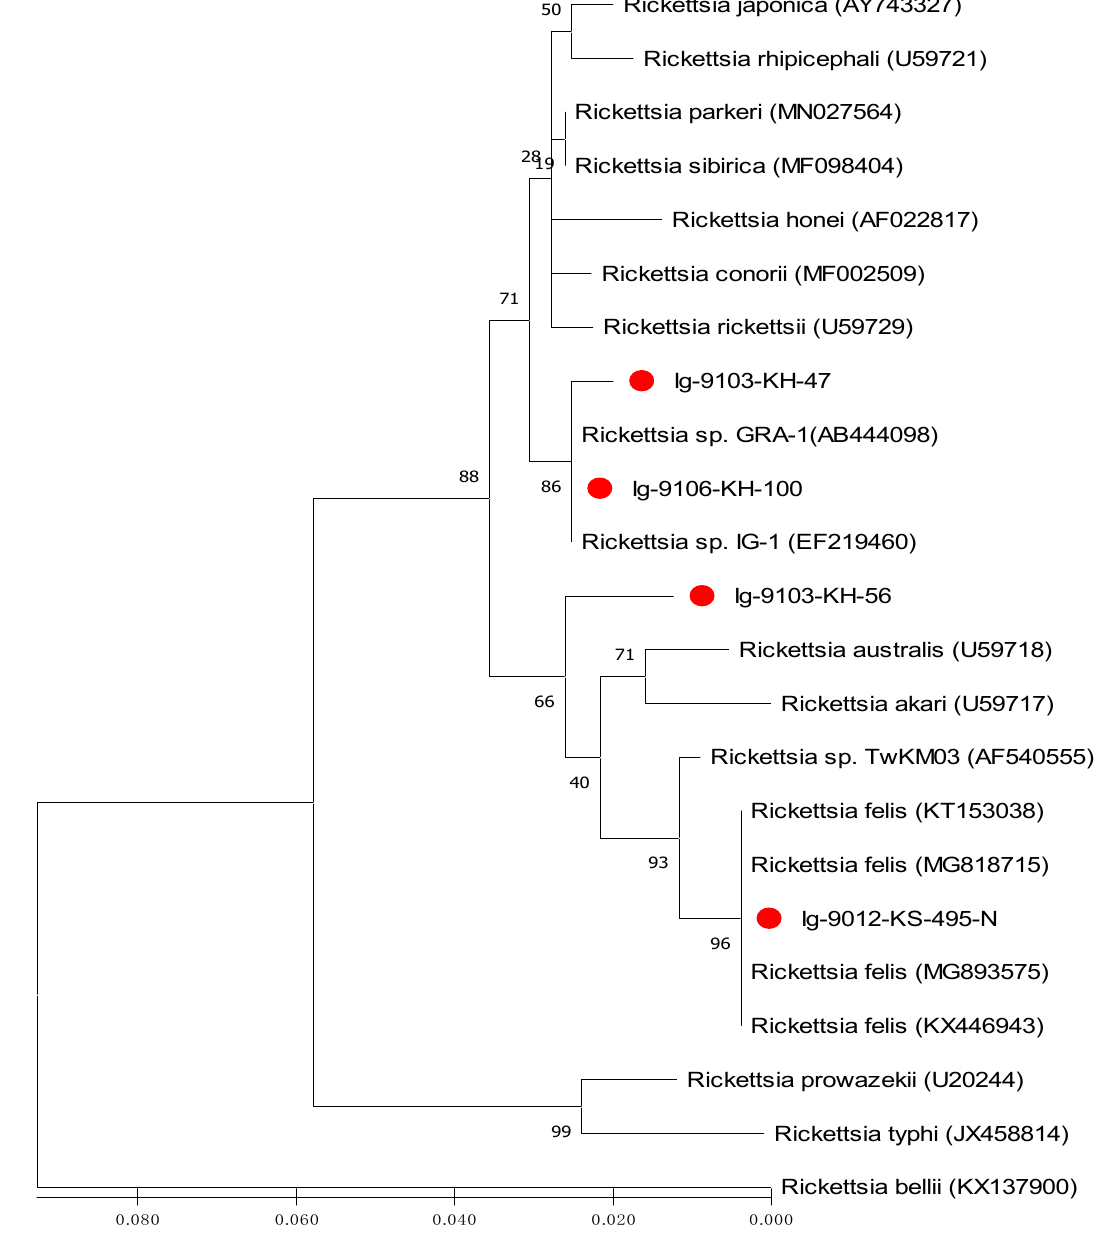
Figure 3. Phylogenetic relationships based on the citrate synthase gene ( gltA ) sequences of Rickettsia between 4 specimens (indicated as ●) collected from Ixodes granulatus ticks of Kinmen Island and 19 other Rickettsia specimens identified from various biological and geographical origins. The tree was constructed and analyzed by maximum likelihood (ML) method using 1000 bootstraps replicates. Numbers at the nodes indicate the percentages of reliability of each branch of the tree. Branch length is drawn proportional to the estimated sequence divergence.